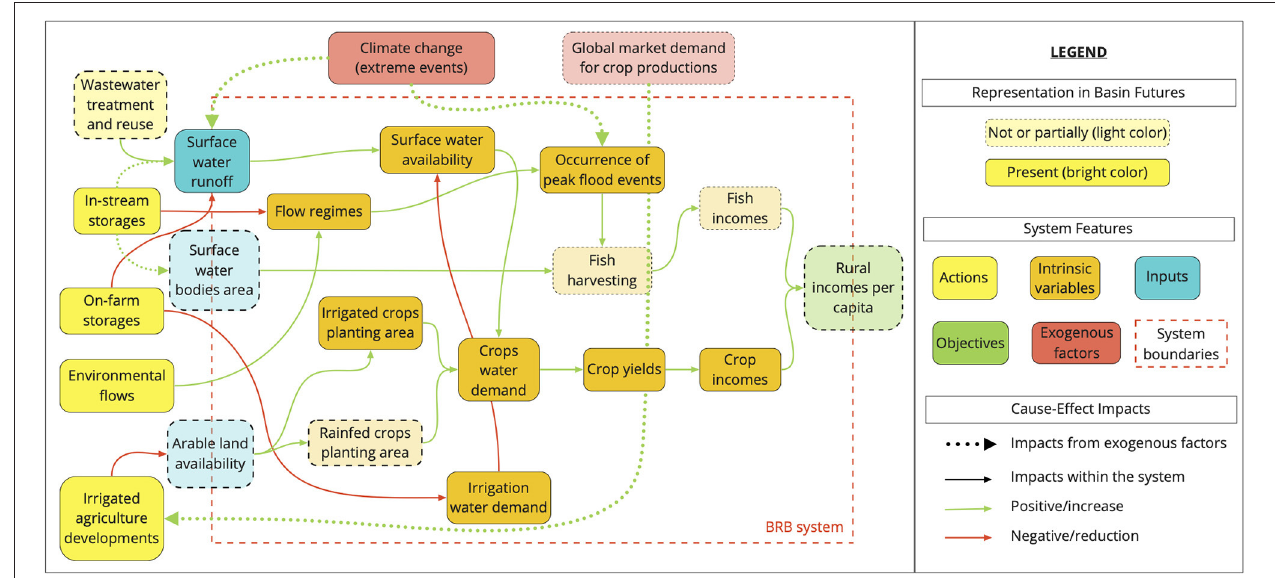
FIGURE 3 | Comparison of the conceptual representations of the BRB from a user perspective and the Basin Futures tool’s